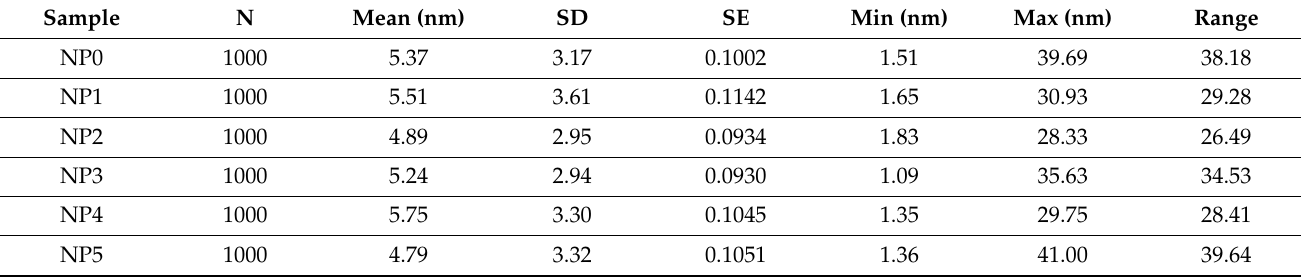
Figure 9. Electron diffraction (ED) patterns of the samples ( a ) NP0, ( b ) NP1, ( c ) NP2, ( d ) NP3, ( e ) NP4, ( f ) NP5. M: magnetite, H: hematite. Table 3. Statistical data of particle size: population of measured particles (N), mean size (nm), standard deviation (SD), standard error (SE), minimum size (Min), maximum size (Max), and